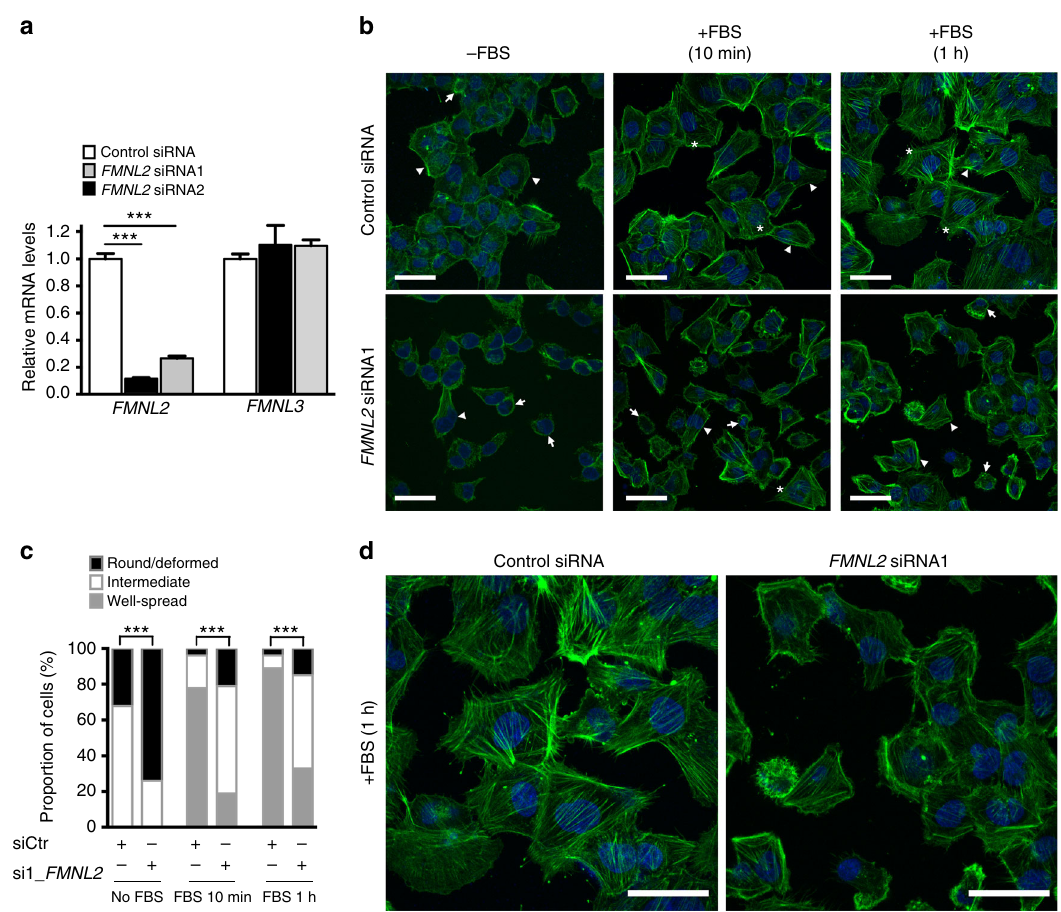
Fig. 3 FMNL2 knockdown modi fi es human trabecular meshwork cell morphology. Following siRNA-mediated knockdown of FMNL2 for 24 h, HTM cells were serum-starved for 24 h in order to disrupt the normal organization of actin fi bers. The cells were then supplemented with fetal bovine serum (FBS) for 10 min or 1 h to induce formation of actin stress fi bers and cell spreading. a Both the FMNL2 siRNA1 and -siRNA2 caused signi fi cant knockdown of FMNL2 mRNA as assessed by qPCR. The expression of FMNL3 , a paralog of FMNL2 was not altered. b Fluorescent microscopic images of phalloidin-FITC-stained F- actin shows that the actin stress fi bers are poorly detectable in serum-starved control siRNA-transfected cells ( − FBS), and following treatment with FBS ( + FBS for 10 min or 1 h) the stress fi bers are prominently visible. Consistent with appearance of actin stress fi bers, the control siRNA-transfected HTM cells treated with FBS for 10 min are well spread. The actin stress fi bers of the FMNL2 -siRNA1 transfected HTM cells are poorly formed even after 1 h treatment with FBS. Moreover, many of these cells appear deformed/rounded or in general exhibiting poor cell spreading. c A bar graph showing proportion of cells (show as percentage) in each of the three groups of cells with distinct morphology (see Methods). In presence of FBS, the percentage of deformed/rounded or modestly spread cells (intermediate) is signi fi cantly more in FMNL2 siRNA1 transfected as compared to control siRNA-transfected HTM cells, which primarily show a well-spread morphology. d Magni fi ed fl uorescent miscroscopic images of phalloidin-FITC-stained F-actin presented in b . White arrows indicate cells with deformed/rounded morphology, arrowheads indicate modestly spread cells (intermediate), and asterisks indicate well- spread cells. Results are mean ± s.e.m. of three independent experiments. Signi fi cance of difference was determined by unpaired two-tailed t -test and Pearson ’ Chi-squared test for a and c , respectively. *** P < 0.005. Scale bars = 50 μ